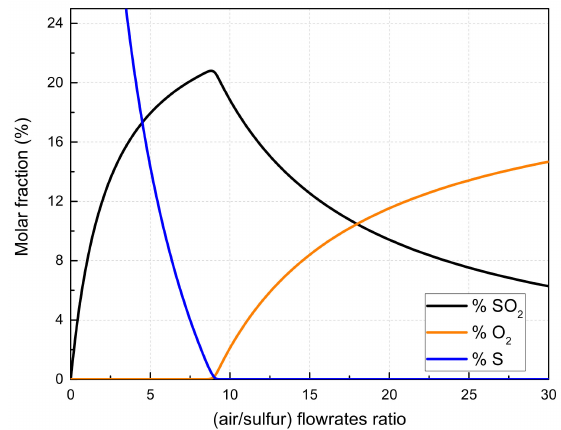
Figure 9. Effect of excess air on the combustion gas composition.